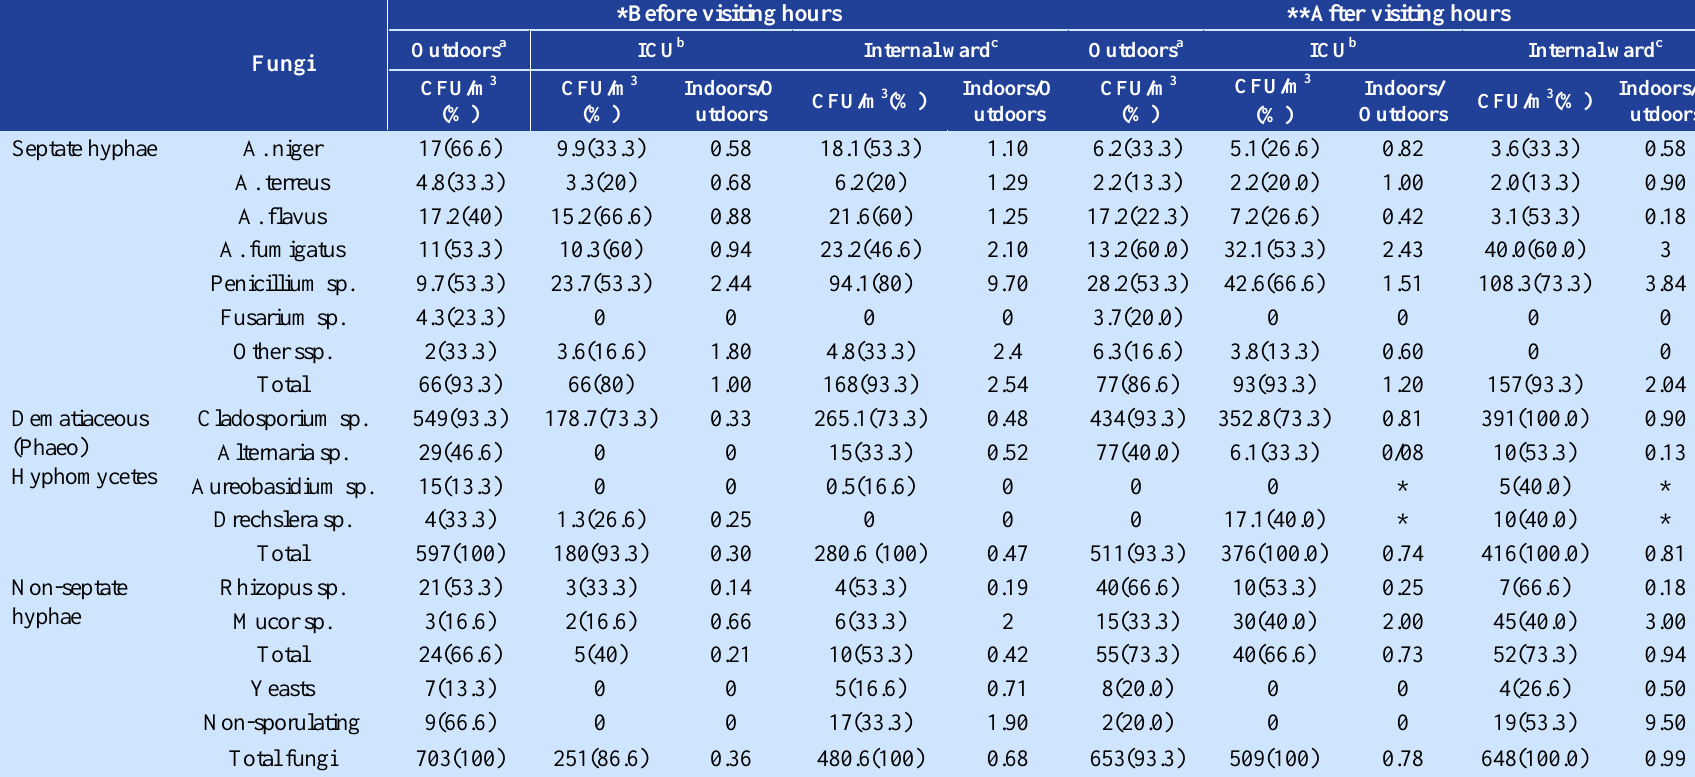
Table 1. Average airborne fungi concentration (CFU/m 3 ) and frequency (%) in indoor and outdoor environments before and after visiting hours